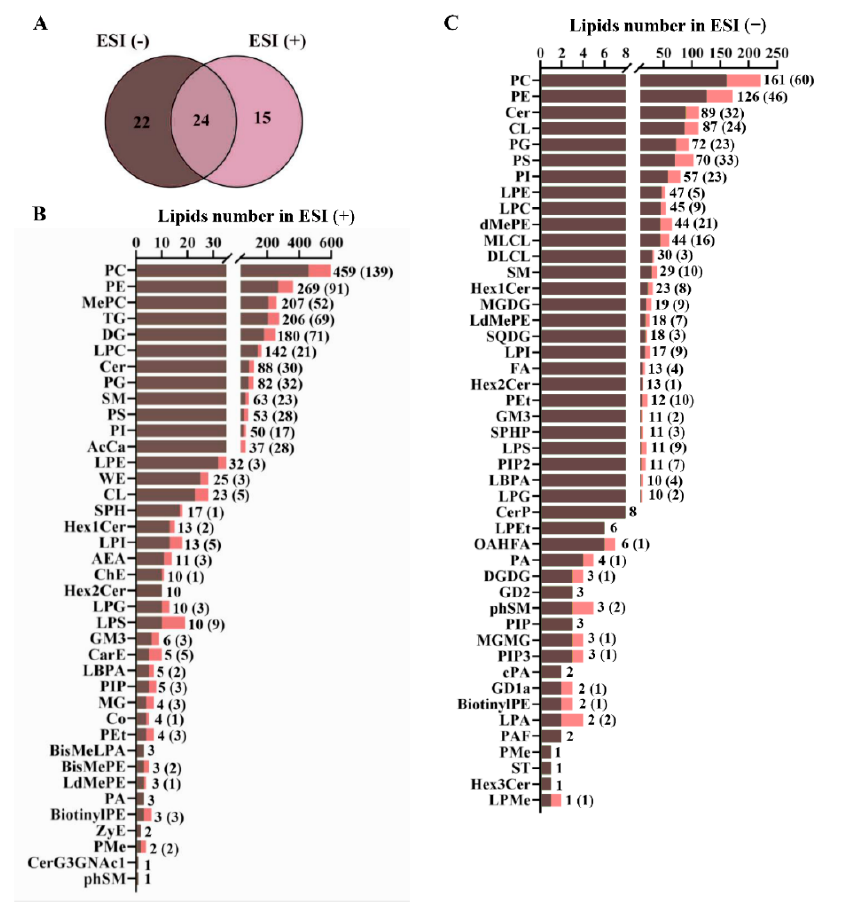
Figure 5. ( A ) Venn diagrams showing the quantity of lipid subclasses detected in positive and negative ion modes. The numbers of identified and significantly differential lipids species in each subclass in positive ion modes ( B ) and negative ion modes ( C ).